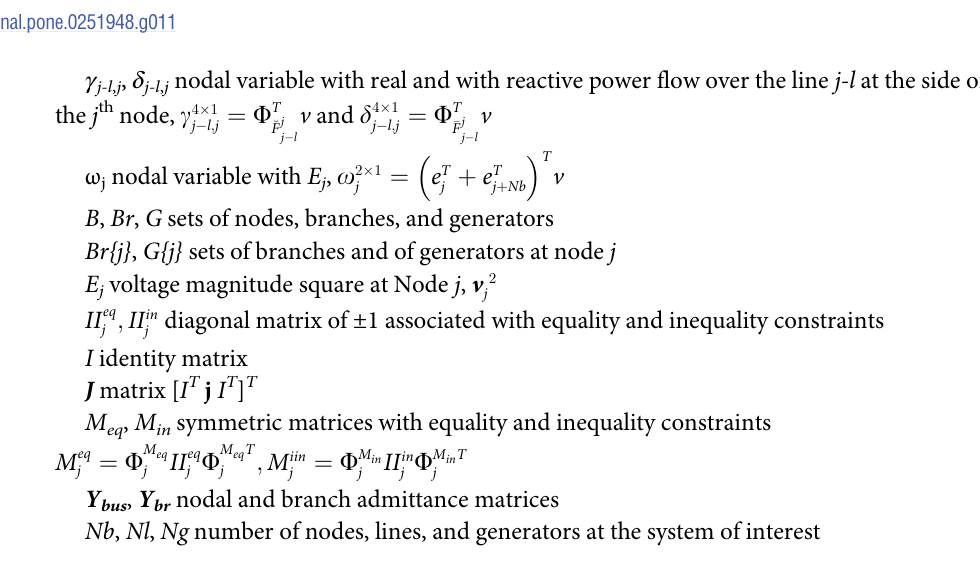
Fig 11. Computation times in seconds for nodal OPF of the maximum cardinality of the nodal variables. Dotted line is the best-fit line with the slope of